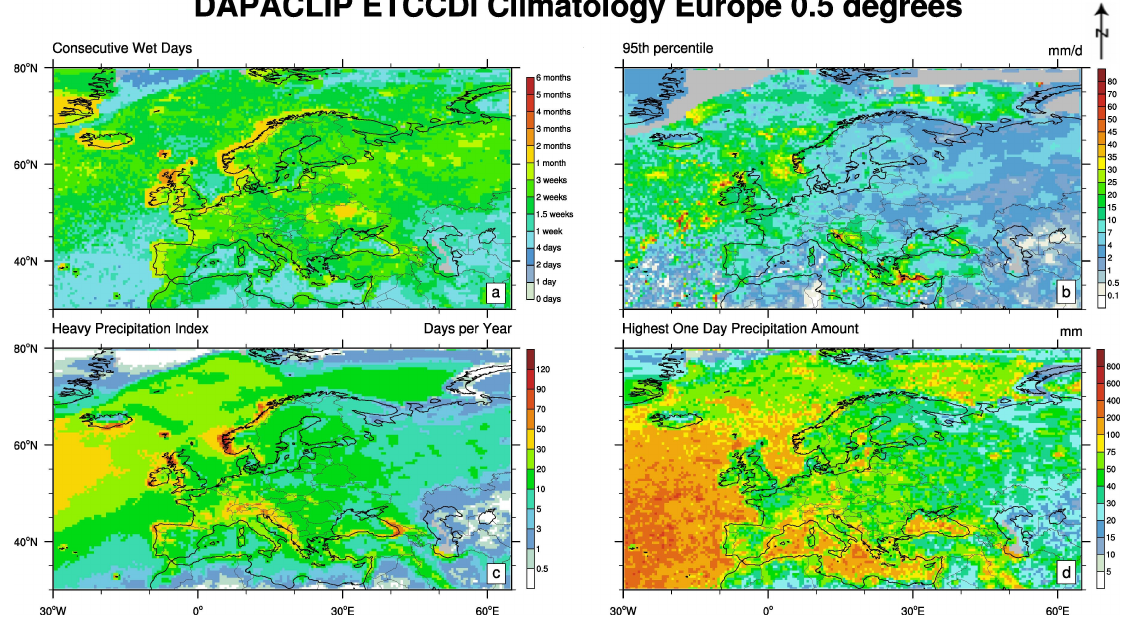
Figure 6. DAPACLIP ETCCDI climatology for the period 1988–2008 for Europe in 0.5 ◦ spatial resolution for selected ETCCDI indices. Panel ( a ): cwd index. Panel ( b ): r95p index. Panel ( c ): r10 index. Panel ( d ): rx1 index.